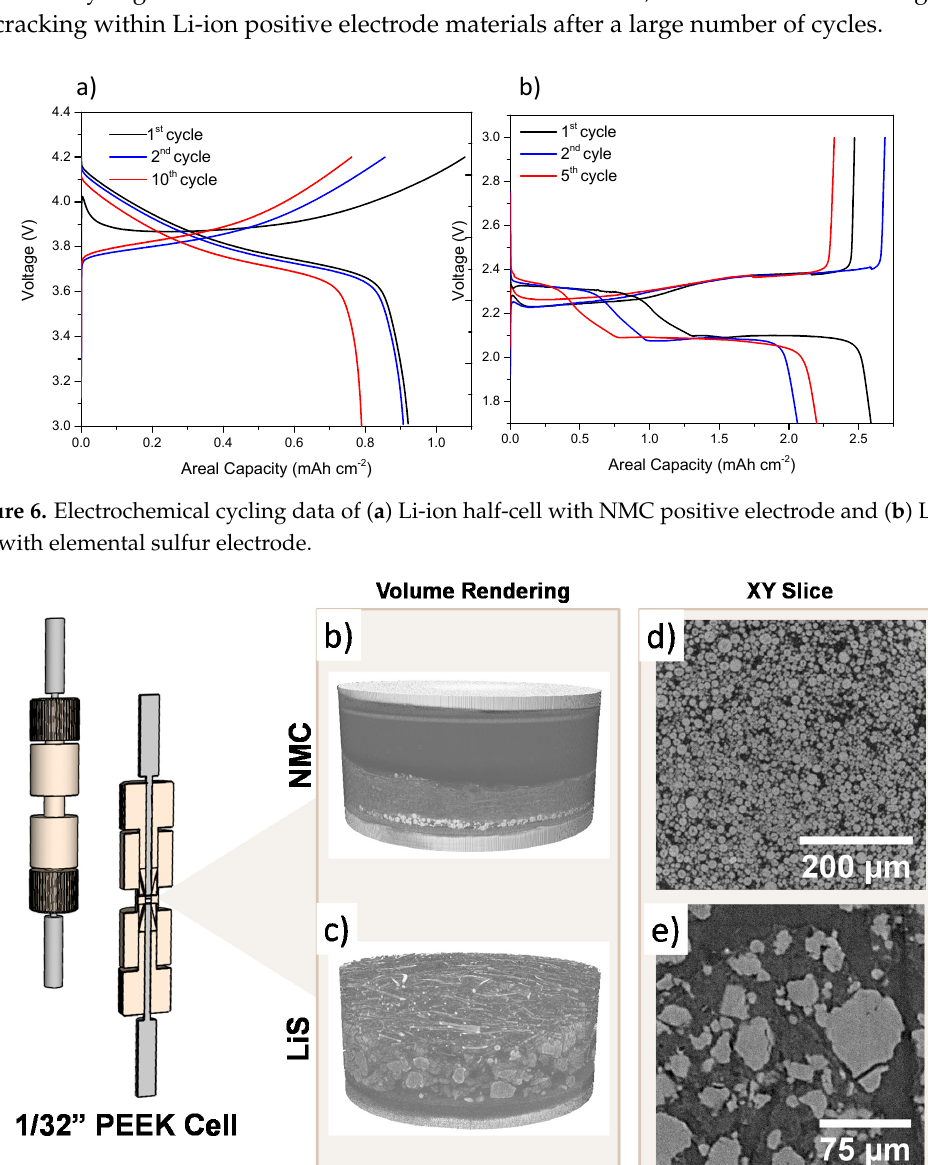
Figure 8. Improvement in image quality between ( a ) coin cell scan performed at a synchrotron facility for an LMO electrode, ( b ) Swagelok-type PFA cell, and ( c ) PEEK cell scans performed with a laboratory micro-CT instrument, Zeiss Xradia Versa 520 for an NMC electrode. Improvements in image quality not only provide better statistics when analyzing electrode level degradation but also enable higher quality segmentation with the possibility of identifying individual particles. Image analysis techniques that were once largely within the domain of ex-situ electrode